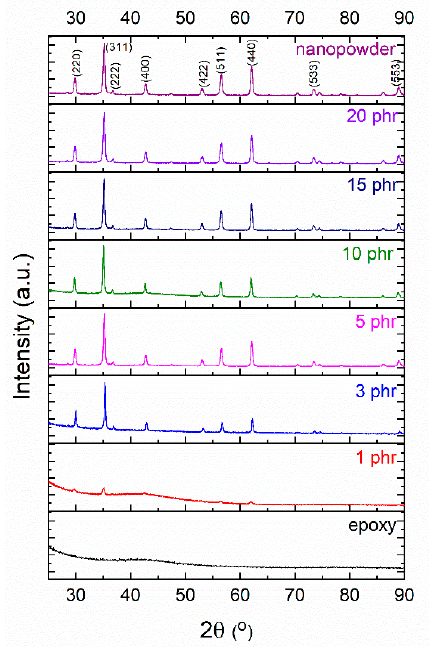
Figure 2. XRD spectra of the ZnFe 2 O 4 nanopowder and its respective nanocomposites.